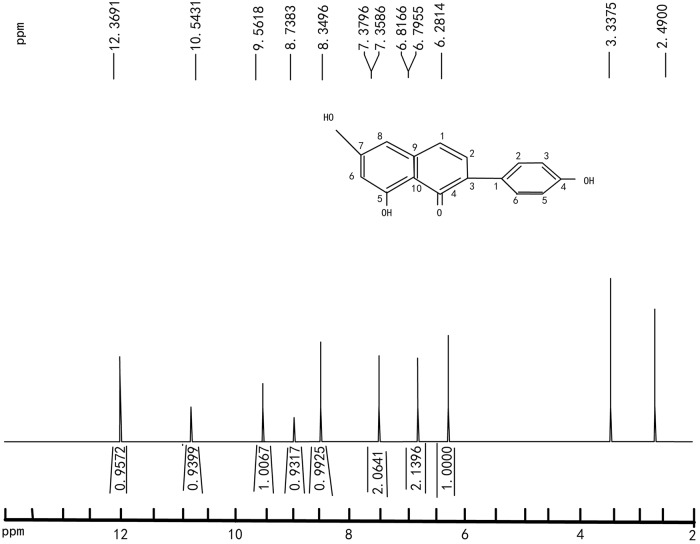
1H-NMR (400 MHz, DMSO-d6) spectrum.